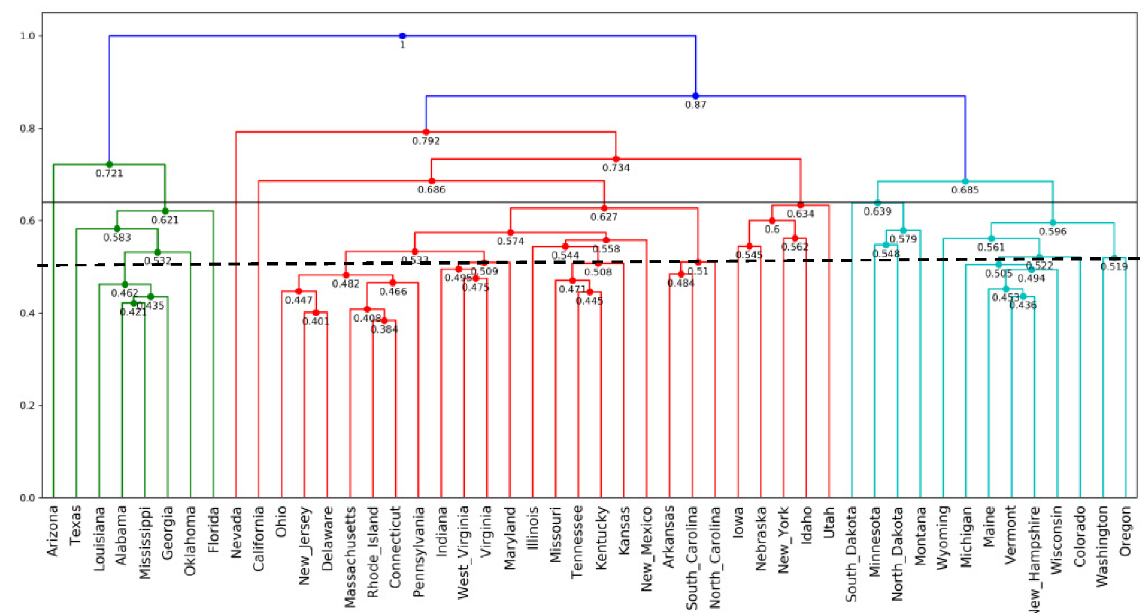
Figure 20. Dendrogram for 12 months.